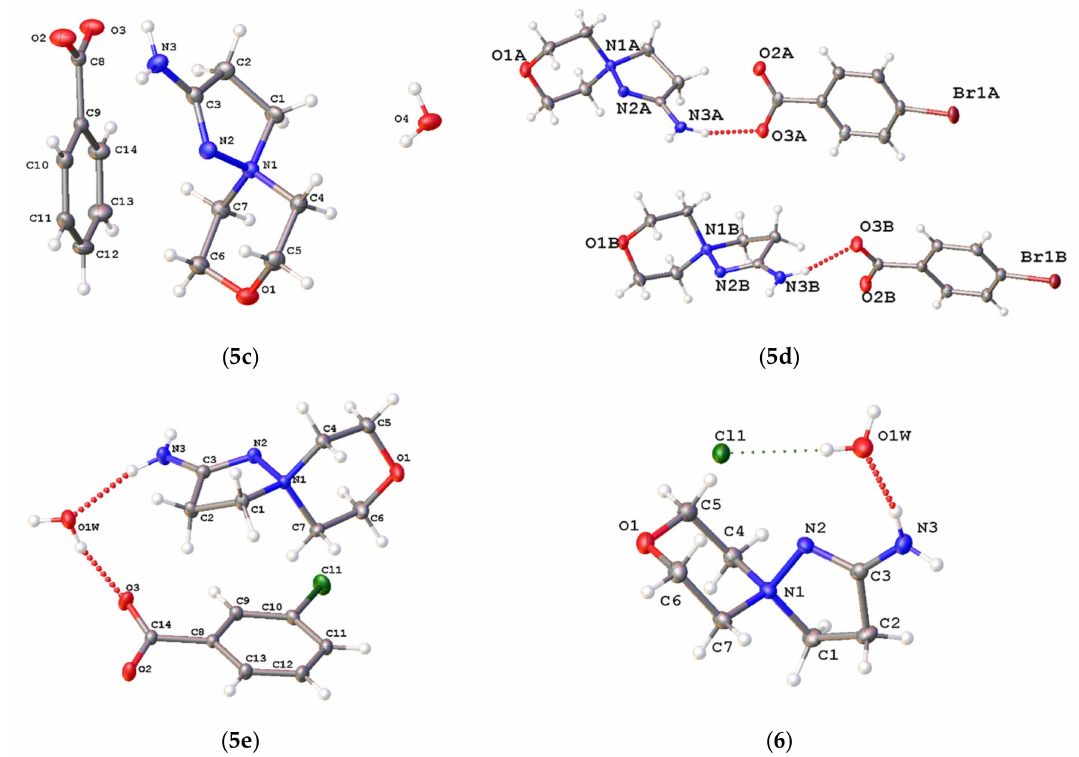
Figure 1. Molecular view of 5c – e and 6 depicted in thermal ellipsoids ( p = 50%).